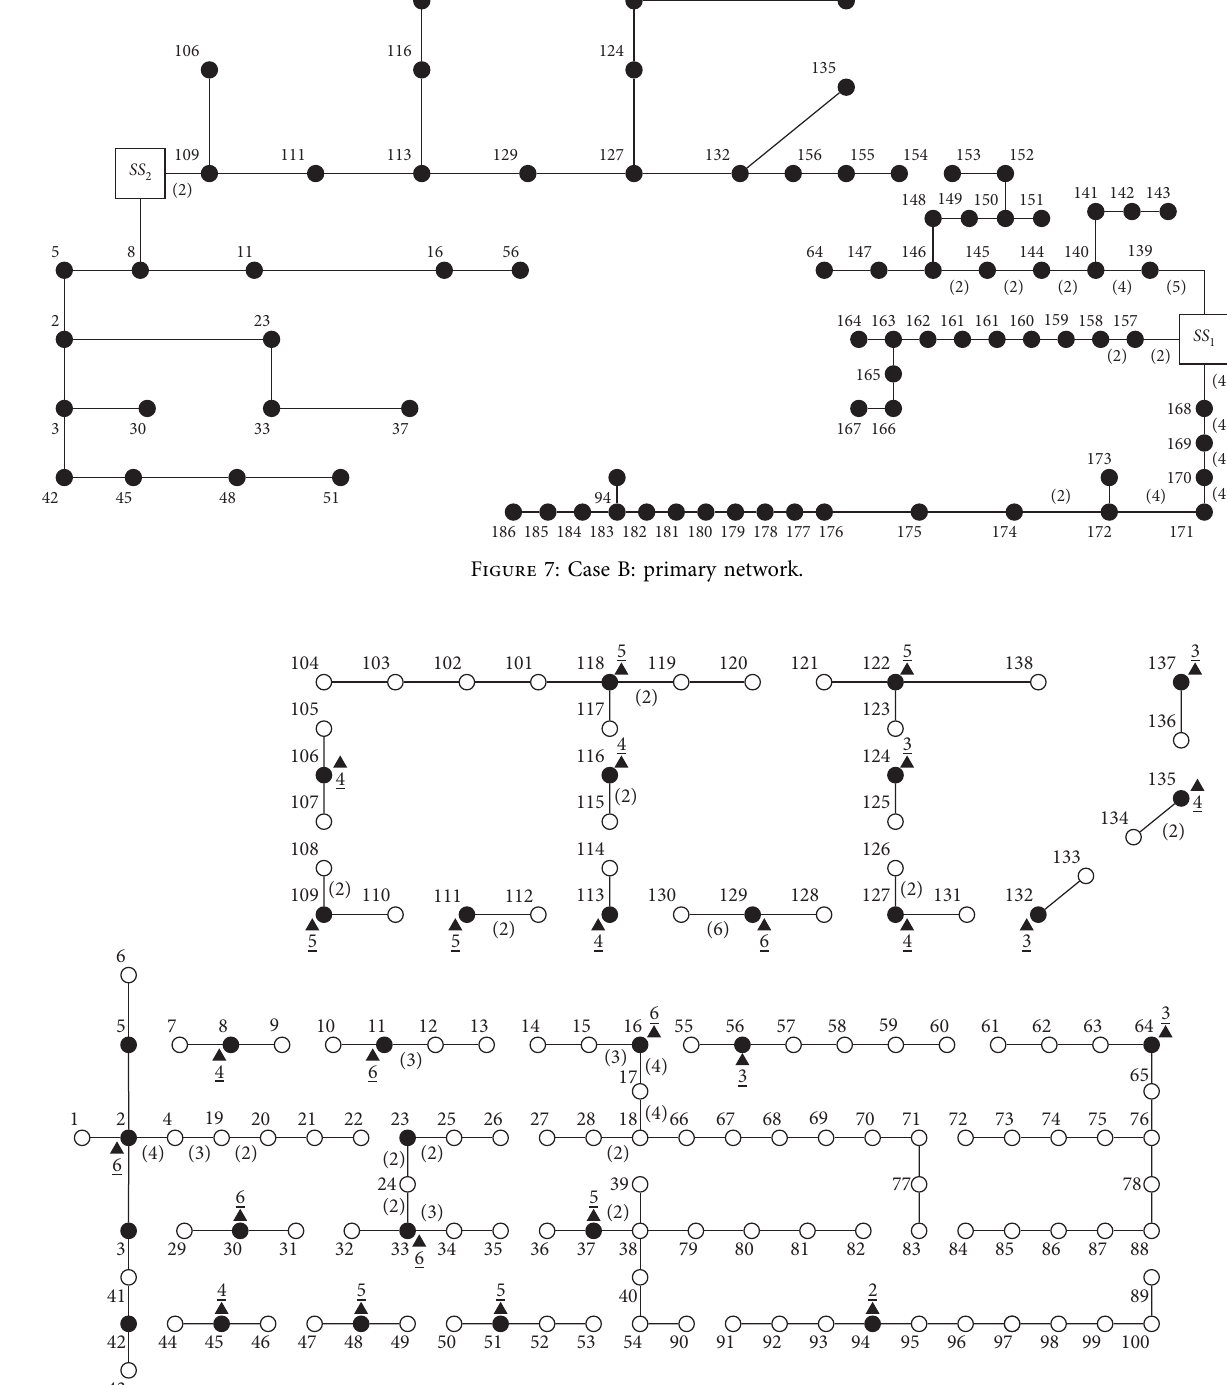
Figure 8: Case B: secondary